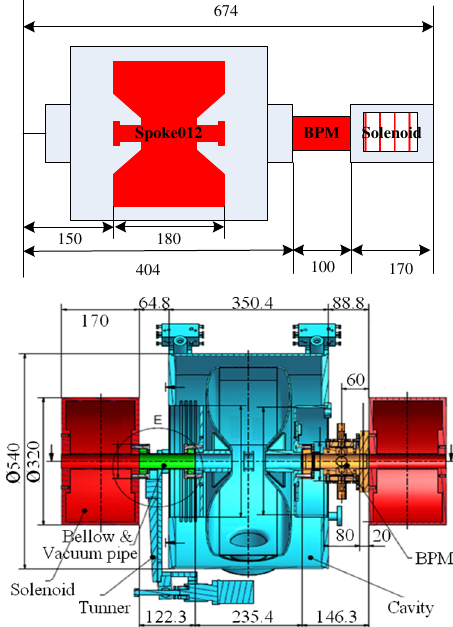
FIG. 9. The lattice structure of the Spoke012 section: physics design (above), mechanical